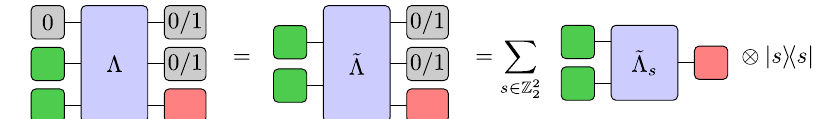
Fig. 2 Block-diagonalizing circuit fragments. Each circuit fragment can be identi fi ed with a density operator Λ on the joint Hilbert space of its input (left) and output (right) qubits. Classical inputs and outputs of a fragment (gray) correspond to qubits that are either prepared in the trivial state 0 j i (labeled “ 0 ” ) or measured in a fi xed computational basis (labeled “ 0/1 ” ). Quantum inputs (left, green) and outputs (right, red) correspond to qubits associated with cuts in a circuit. Due to the presence of trivial inputs, we only need to characterize a reduced state ~ Λ on the Hilbert space of the quantum inputs and all outputs. Classical outputs give this reduced state a block-diagonal structure: P ~ Λ ~ Λ ~ Λ ¼ s (cid:2) s ih s j j , where the block s is associated with the measurement of bitstring s on the classical outputs of the s